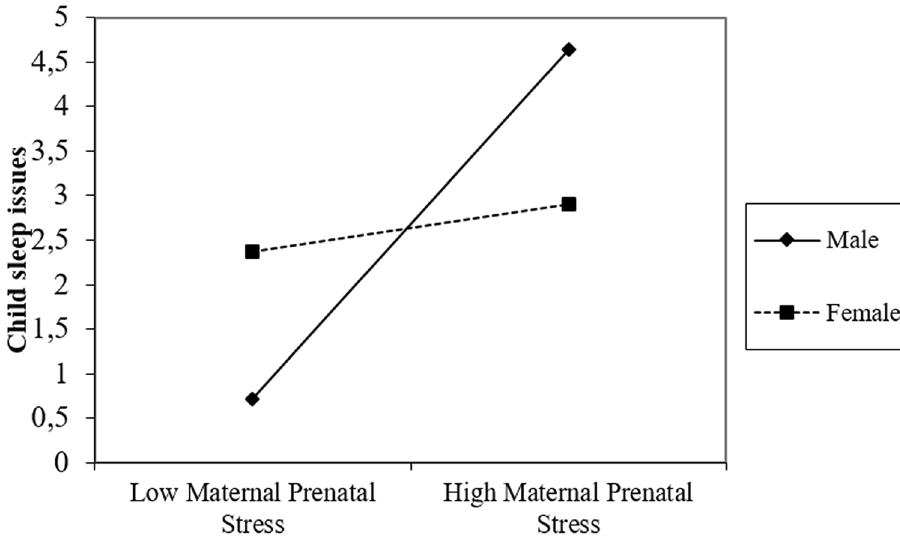
Figure 1. Graphical representation of sex interaction. Sex interaction between maternal prenatal stress and child sleep. Made with excel macro (www.jerem ydaws on.co.uk/slope